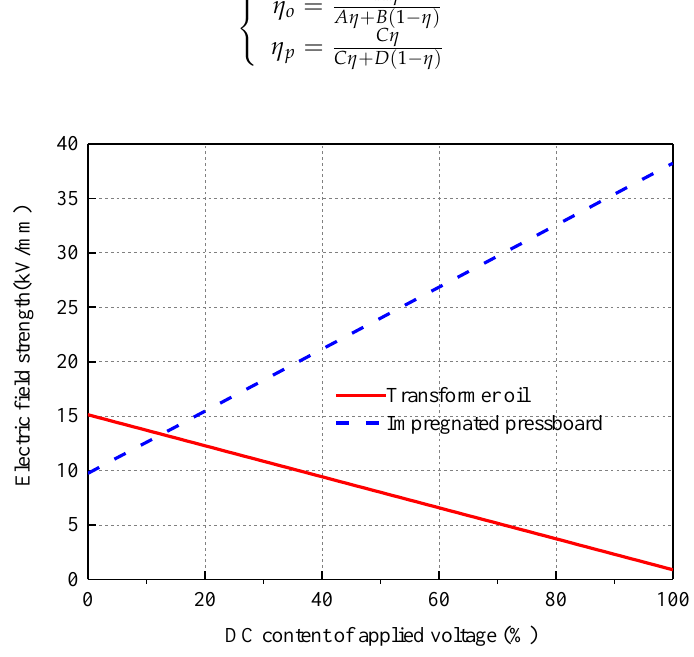
Figure 9. Simulation results of the electric field strengths of transformer oil and pressboard.